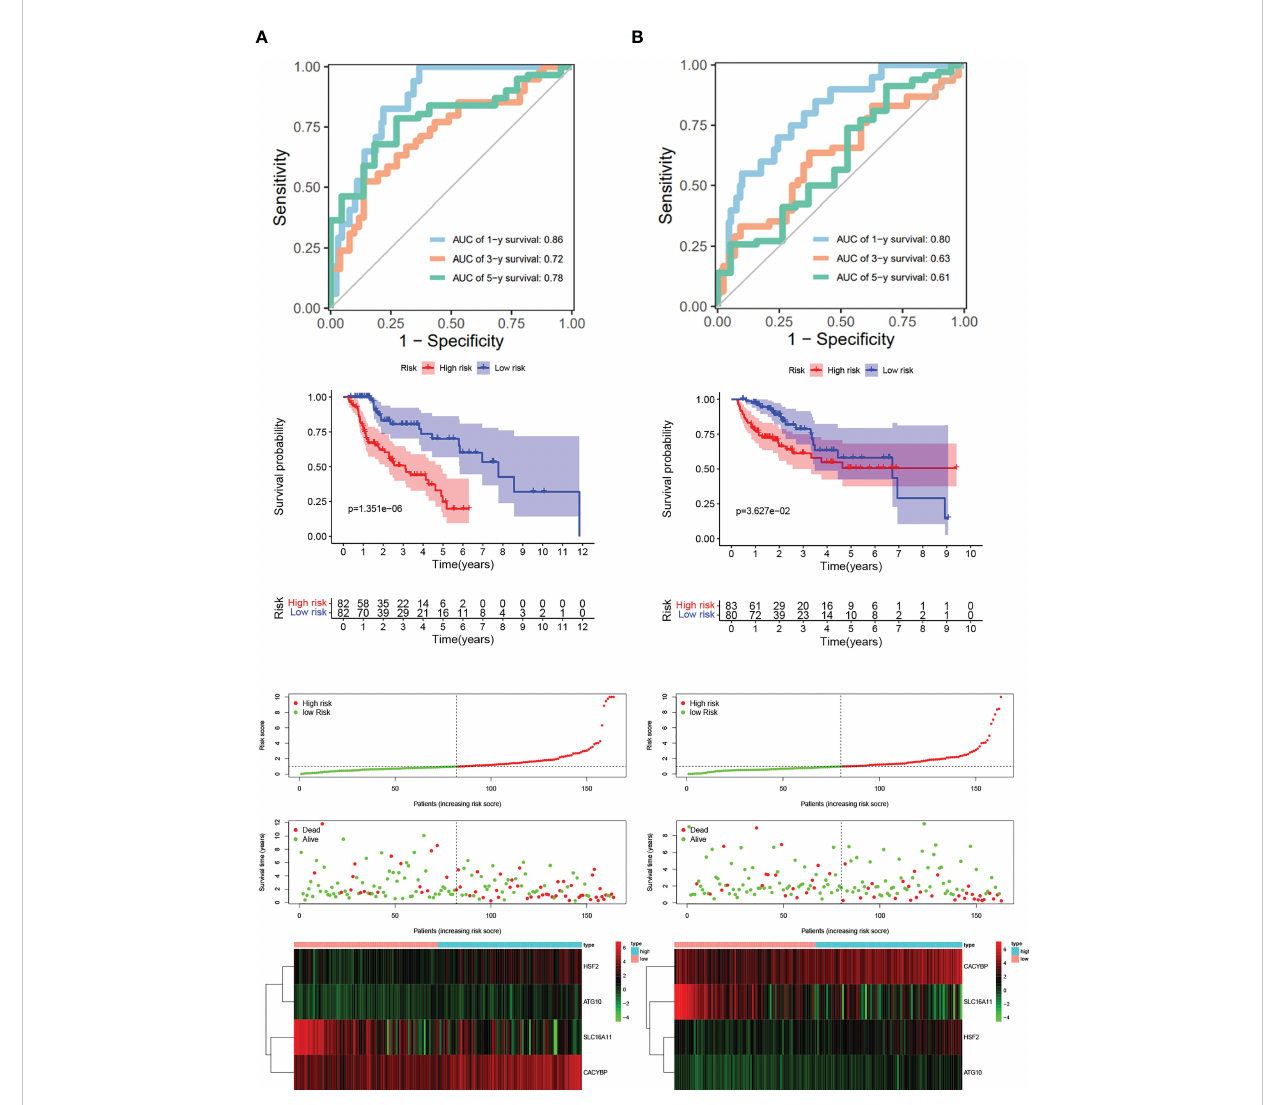
FIGURE 6 Evaluation and veri fi cation of Tex-related HCC prognostic model in TCGA training and testing sets. (A) Kaplan-Meier curve; ROC curves; Scatter plot of the risk score, overall survival, and corresponding heatmap in TCGA training set. (B) Kaplan-Meier curve; ROC curves; Scatter plot of the risk score, overall survival, and corresponding heatmap in TCGA testing